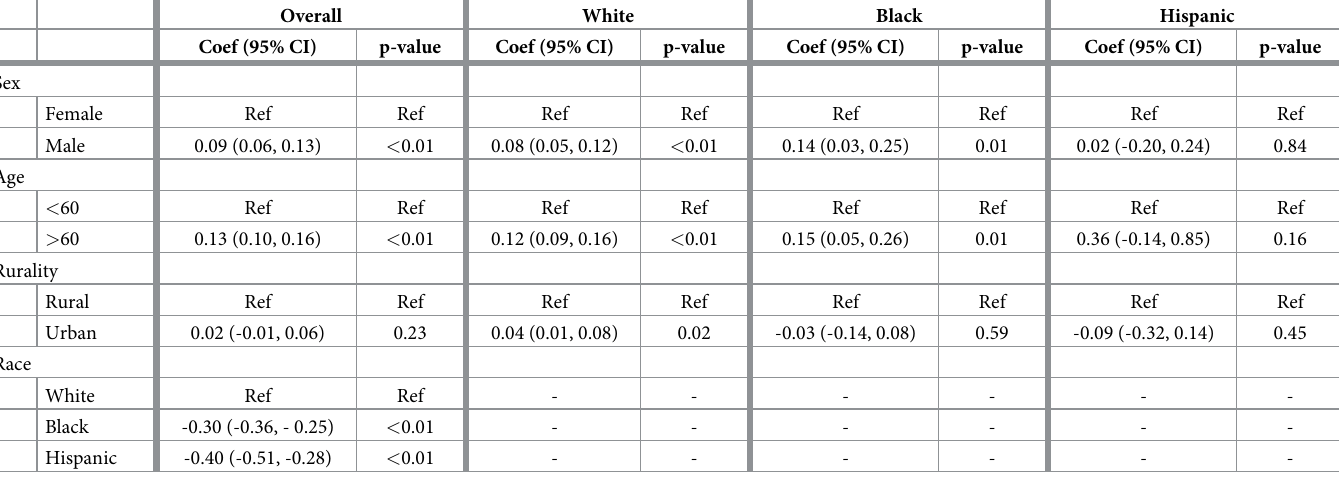
Table 2. Adjusted association of demographic factors with SDOH scores among Arkansans overall and by race and ethnicity from September 5, 2020 to December 18, 2020 a,b . Overall White Black Hispanic Coef (95% CI) p-value Coef (95% CI)